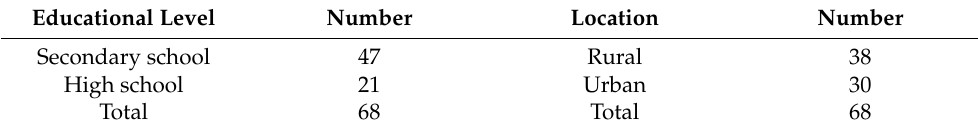
Table 3. Active clubs in the Bacau